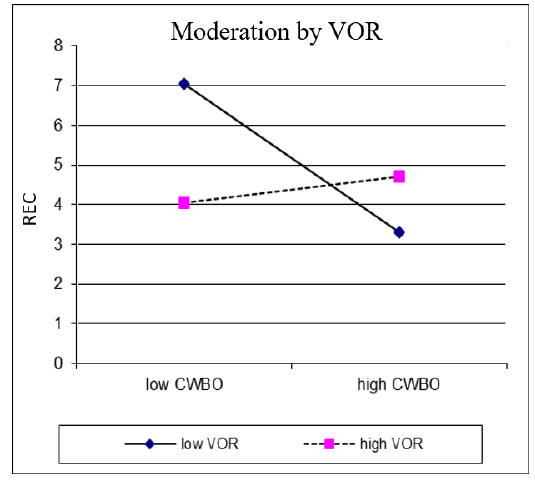
Figure 5. VOR Moderation Effect. Table 6. Study 1 Results.